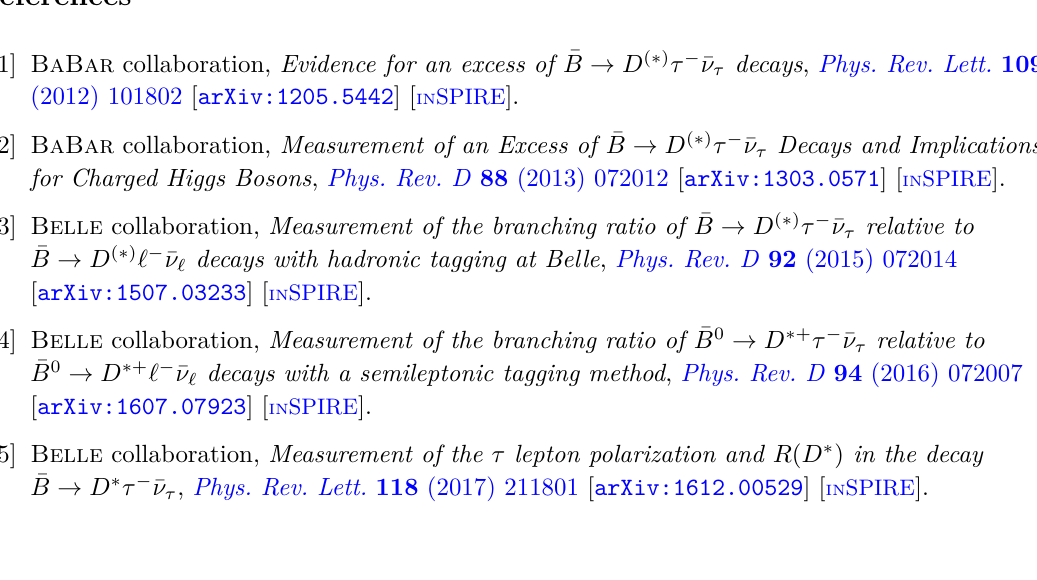
Table 5 . Predictions for the angular moments b F d in the SM and the same NP scenarios considered in table